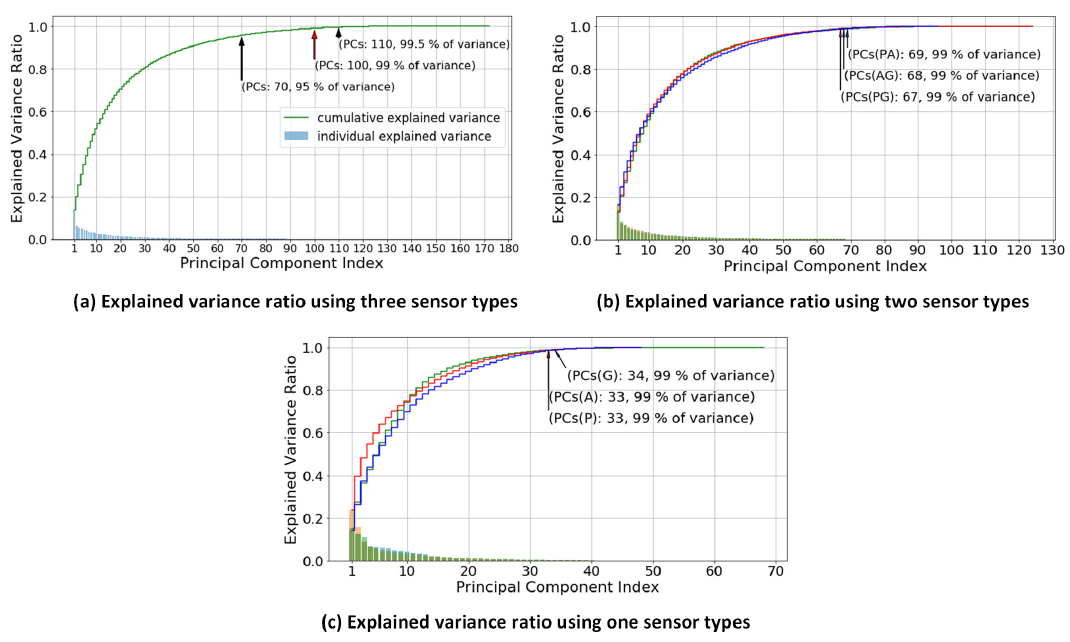
Figure 5. Individual and cumulative explained variances for determining the optimal number of principal components. The cumulative explained variance shows the accumulation of variance for each principal component number. The individual explained variance describes the variance of each principal